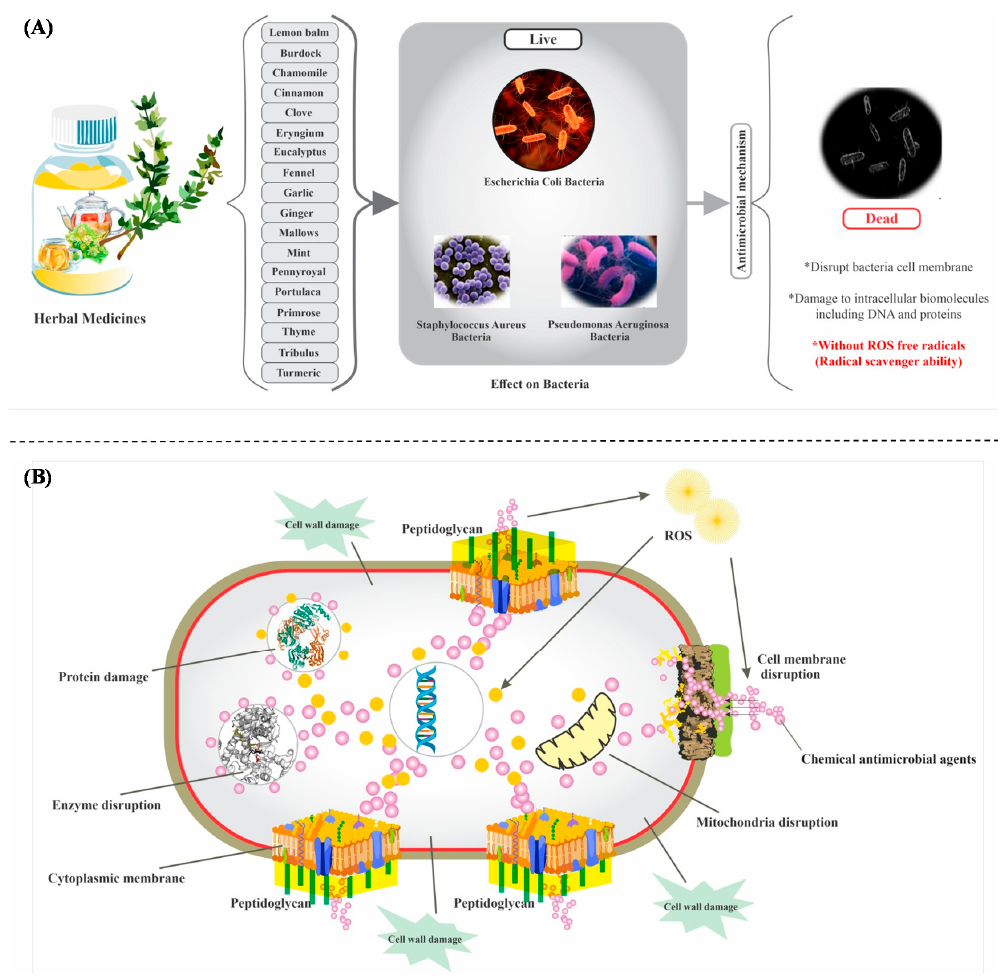
Figure 4. The antimicrobial mechanisms of herbal antimicrobial agents (A) against chemical antimicrobial agents (B) [34,35].